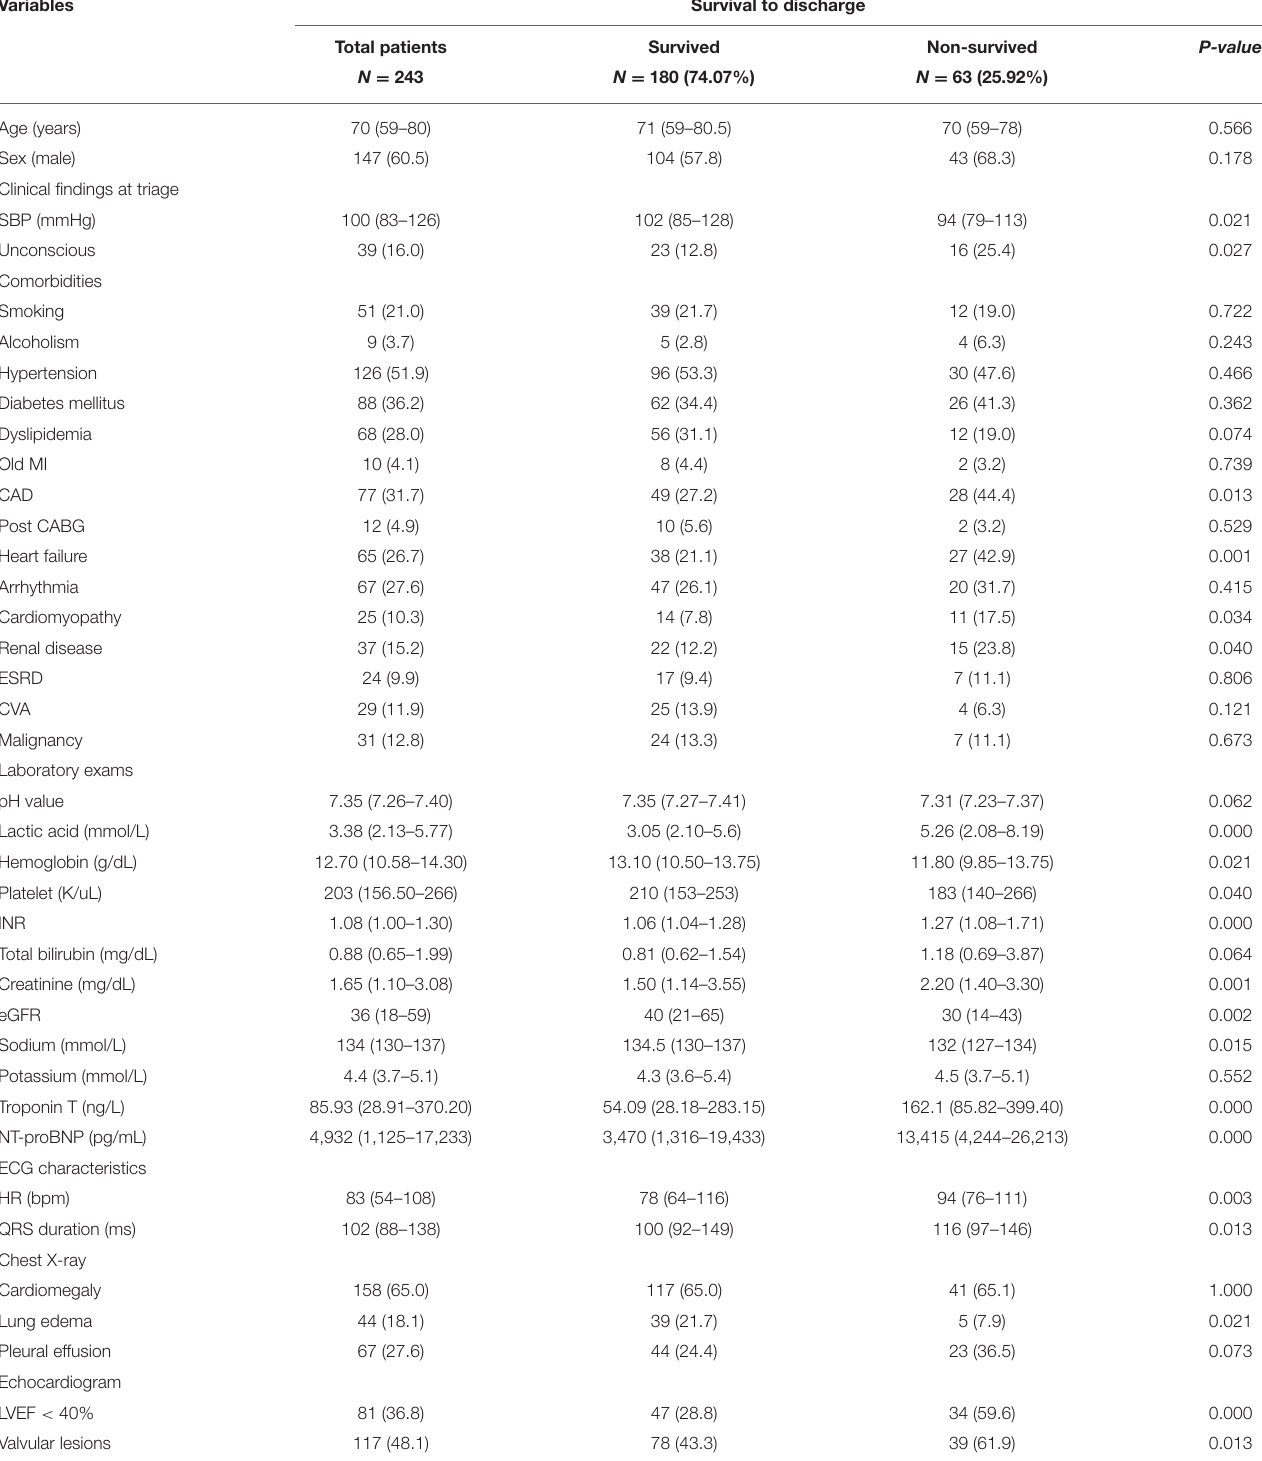
TABLE 1 | Baseline characteristics and examination results between groups in the derivation